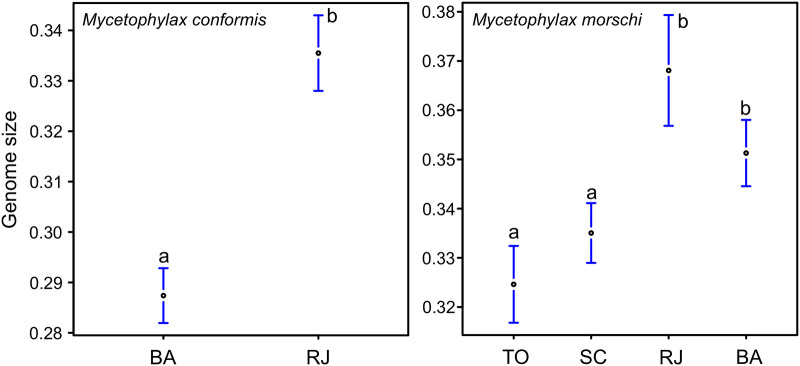
The range of genome sizes (GS) estimated for (a) Mycetophylax conformis, and (b) Mycetophylax morschi.The dots represent the mean, and the bars, the confidence intervals. The x axis corresponds to the locality from which the colony was obtained, while the y axis shows the 1C values in picograms (pg). Each letter from (a) to (b) represents a significant group of mean values (p < 0.05) recovered from the contrast analysis between colonies.